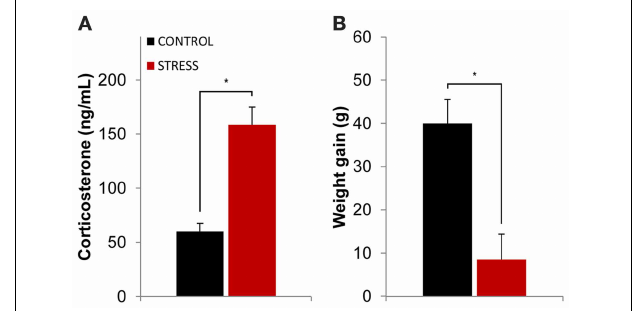
FIGURE 1 | Efficacy of the stress protocol. (A) Plasmatic corticosterone levels measured on the day following the final exposure to the OF arena (which also corresponded to the day after the stress protocol ended). Stressed animals showed higher levels of plasmatic corticosterone than controls at the end of the stress protocol. (B) Body weight gain measured as the difference between the animal’s weight at the beginning and ending of the stress protocol for control and stressed animals. Stressed animals showed higher levels of plasmatic corticosterone than controls at the end of the stress protocol as well as reduced body weight gain. ∗ p < 0 . 05 for unpaired Wilcoxon rank sum test comparison of average plasmatic corticosterone and body weight gain between control and stress groups. Error bars: ±